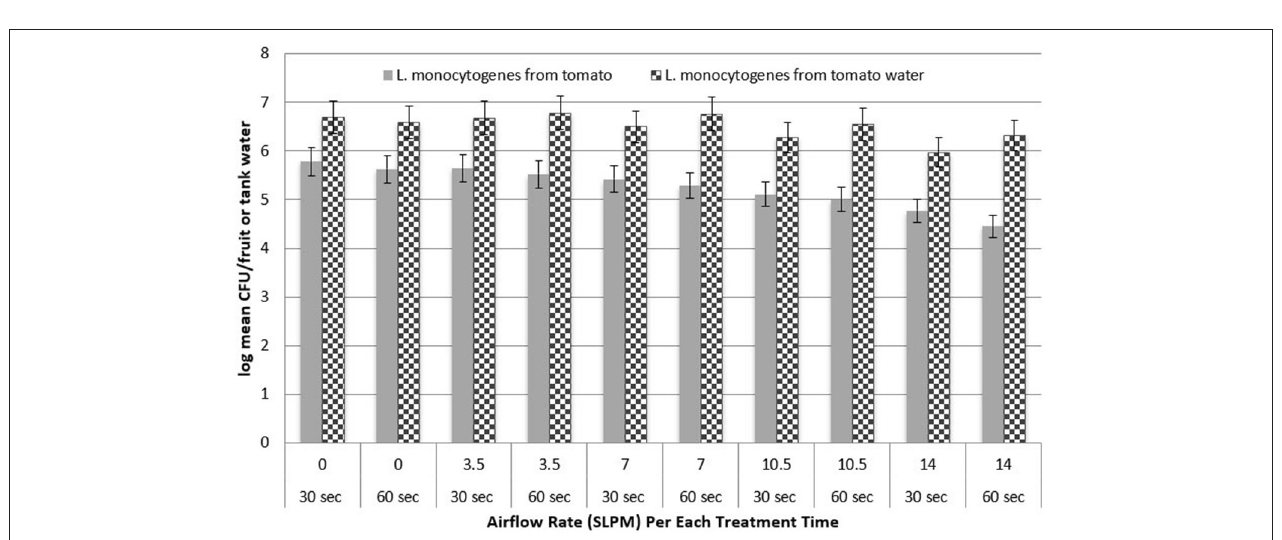
FIGURE 3 | Recovery of inoculated L. monocytogenes from the surface of Roma tomatoes and recovered from the water post-treatment ( n = 3).